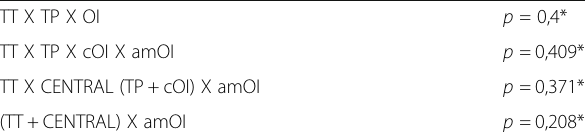
TT transtibial, TP Transportal, OI Outside-In, cOI Central Outside-In, amOI AM Outside-in, CENTRAL (TP+cOI). *